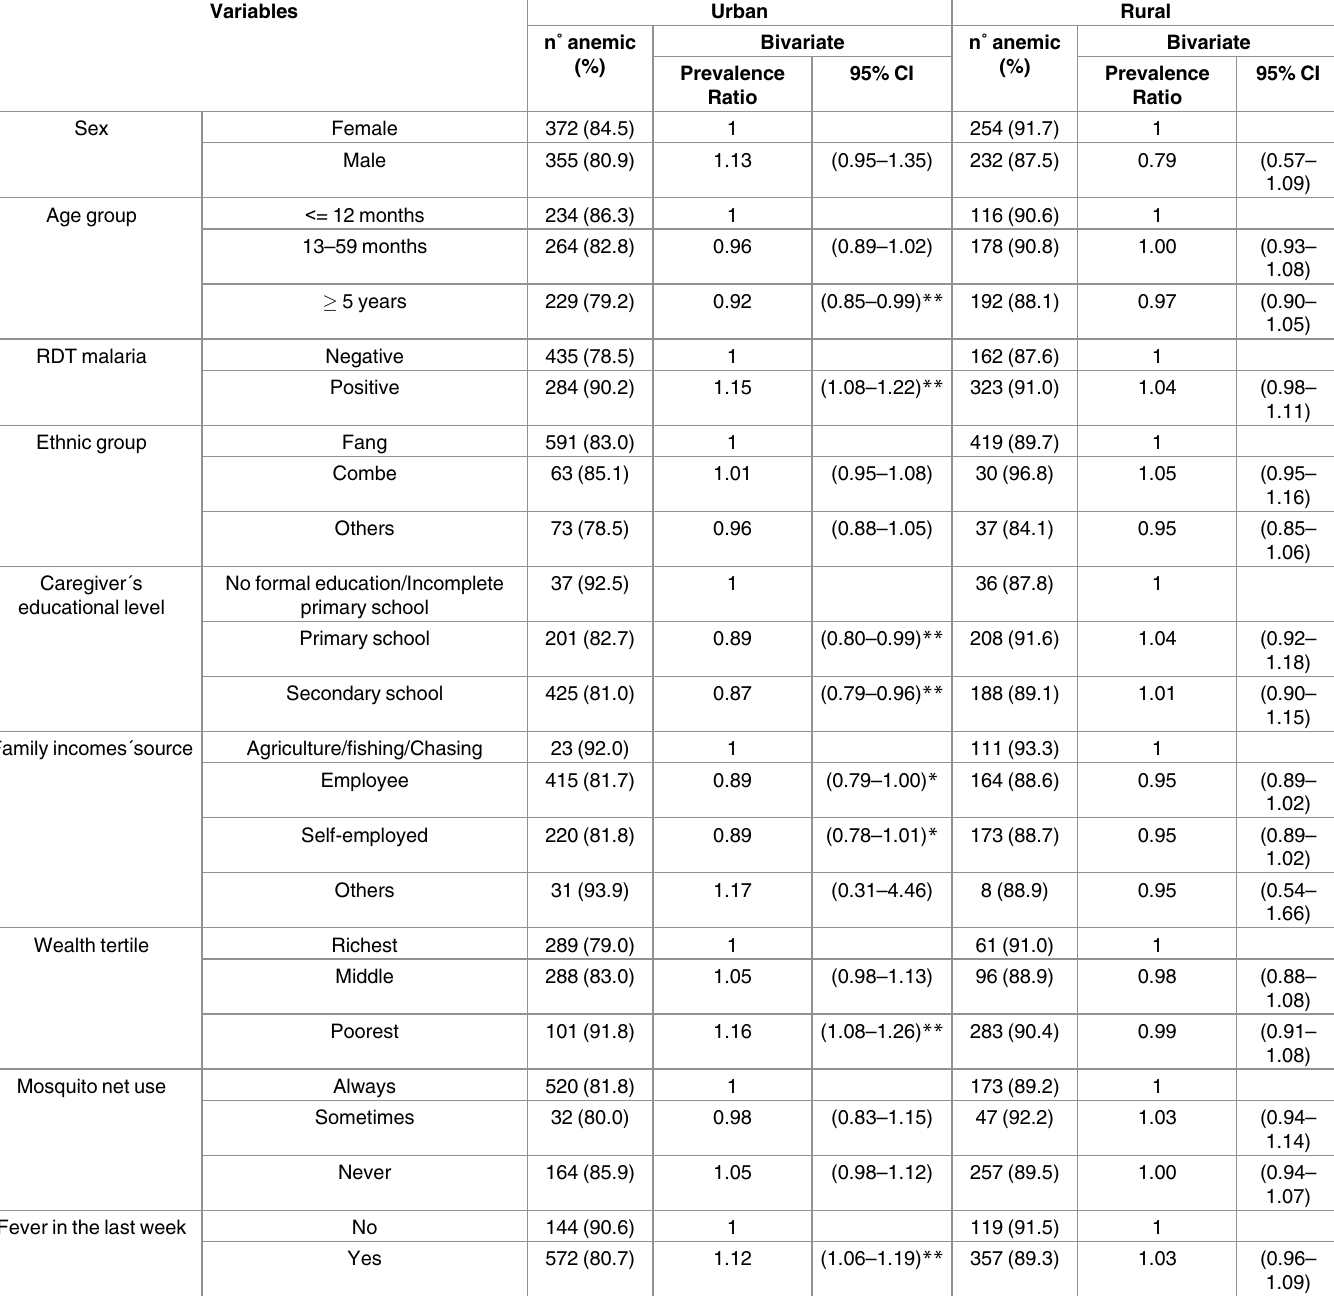
Table 4. Factors associated with anemia in children aged 2 months-15 yearsold, Bata district, June-August